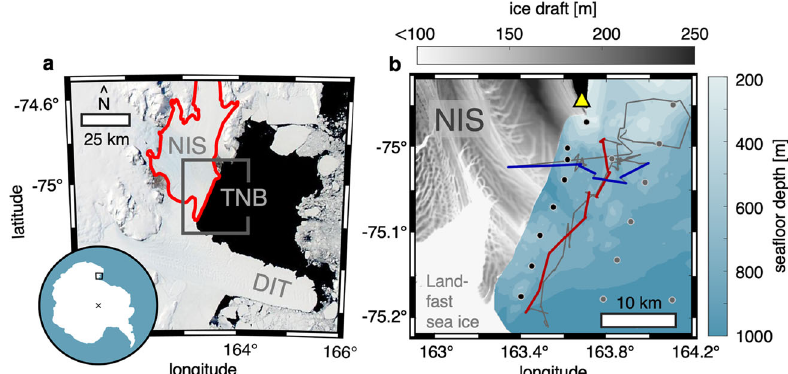
Fig. 1 Site map. a MODIS imagery (NASA Worldview) of the study site from 5 January 2019, showing Terra Nova Bay (TNB), the Nansen Ice Shelf (NIS; red outline), and the Drygalski Ice Tongue (DIT). b Ice draft, sea fl oor bathymetry, and collected data. Colored lines indicate glider transects directed approximately parallel to (NE-SW; red) and perpendicular to (E-W; blue) the NIS calving front. Black circles indicate ship CTD/LADCP pro fi les along a transect parallel to ice shelf front. Grey lines/circles indicate other collected glider/ship data not included in these transects. The yellow triangle indicates the location of Automatic Weather Station Manuela on Inexpressible